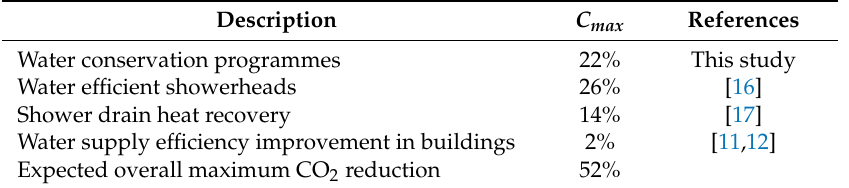
Table 2. Maximum CO 2 reductions ( C max ) estimated for showering in Hong Kong. Description C